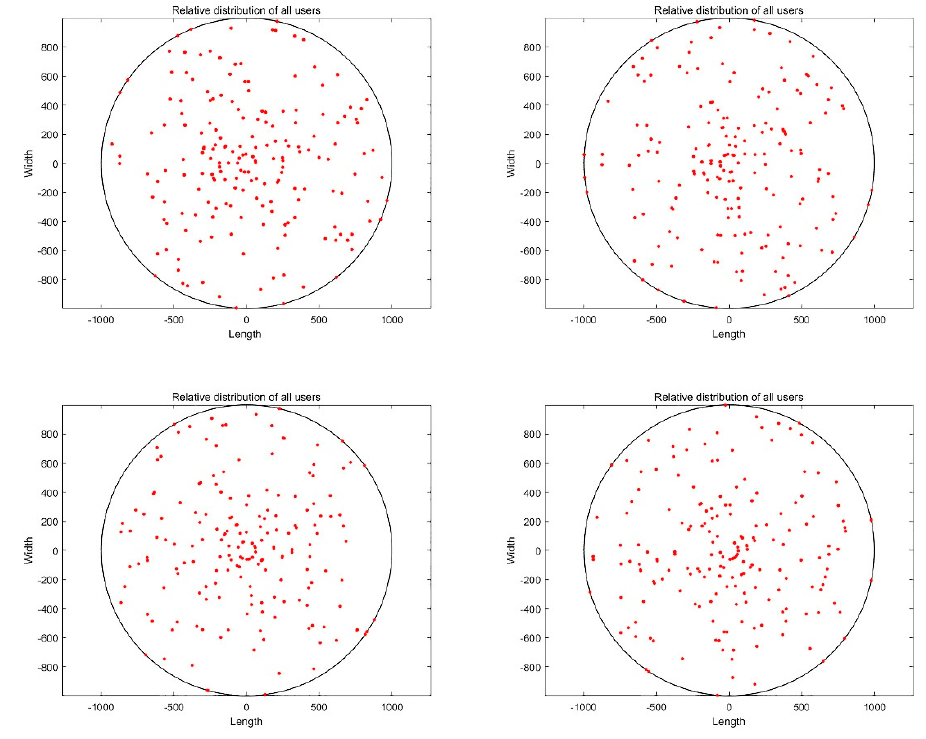
Figure 4. Relative distribution of all users in the area.